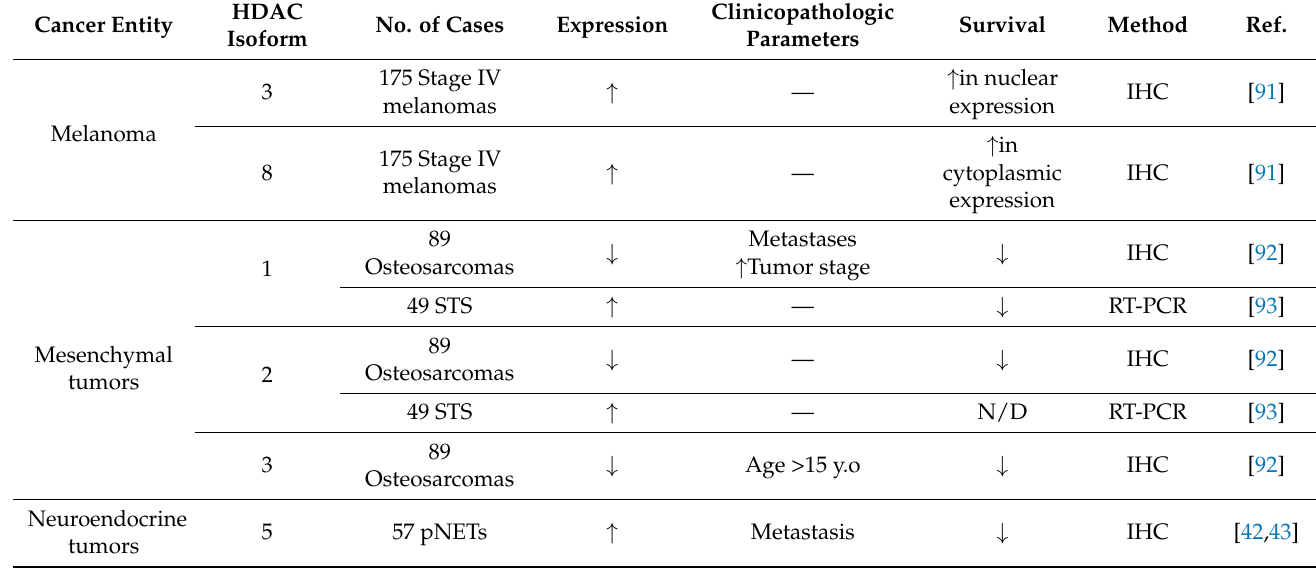
Table 6. Association of different HDAC isoforms expression in other types of tumors and their correlation with clinico- pathological parameters and patients’